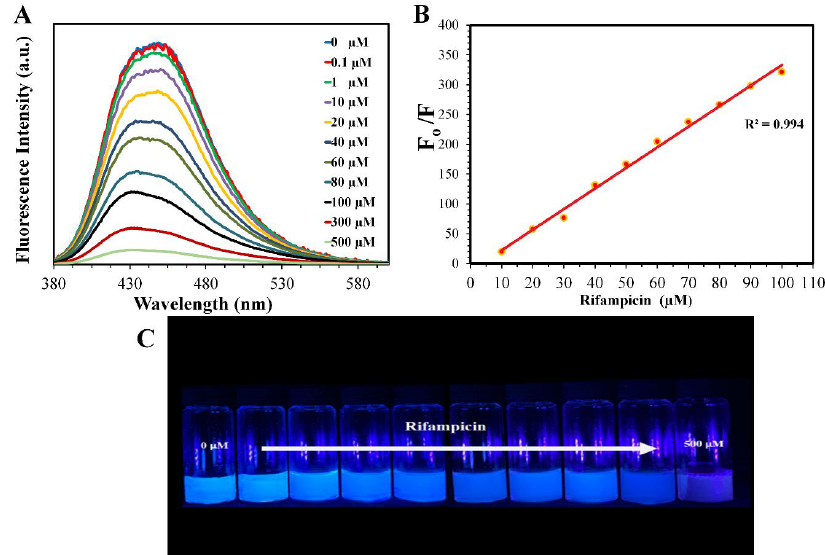
Figure 7. ( A ) Fluorescence spectra of the CNDs with the addition of different concentrations of rifampicin. ( B ) Graph of F 0 /F versus the concentration of rifampicin, where F 0 is the fluorescence intensity when there was no rifampicin and F is the fluorescence intensity when rifampicin was added. ( C) The digital micrograph showing the addition of various concentrations of rifampicin to the CND solutions.